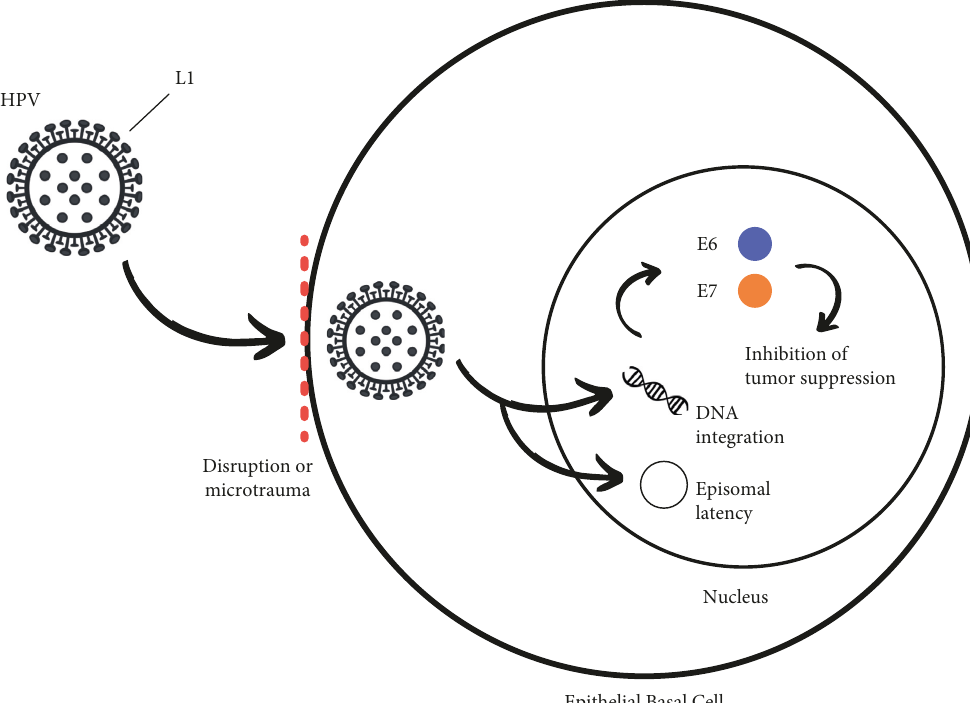
Figure 1: Mechanism of oral infection and carcinogenesis of HPV. In the presence of microtrauma of the basal epithelium of the host cell, HPV enters through interaction between the L1 proteins of its capsid and cell surface receptors. It is then incorporated into the cell nucleus where it can either remain in an episomal state or undergo DNA integration. E6 and E7 proteins inhibit tumor